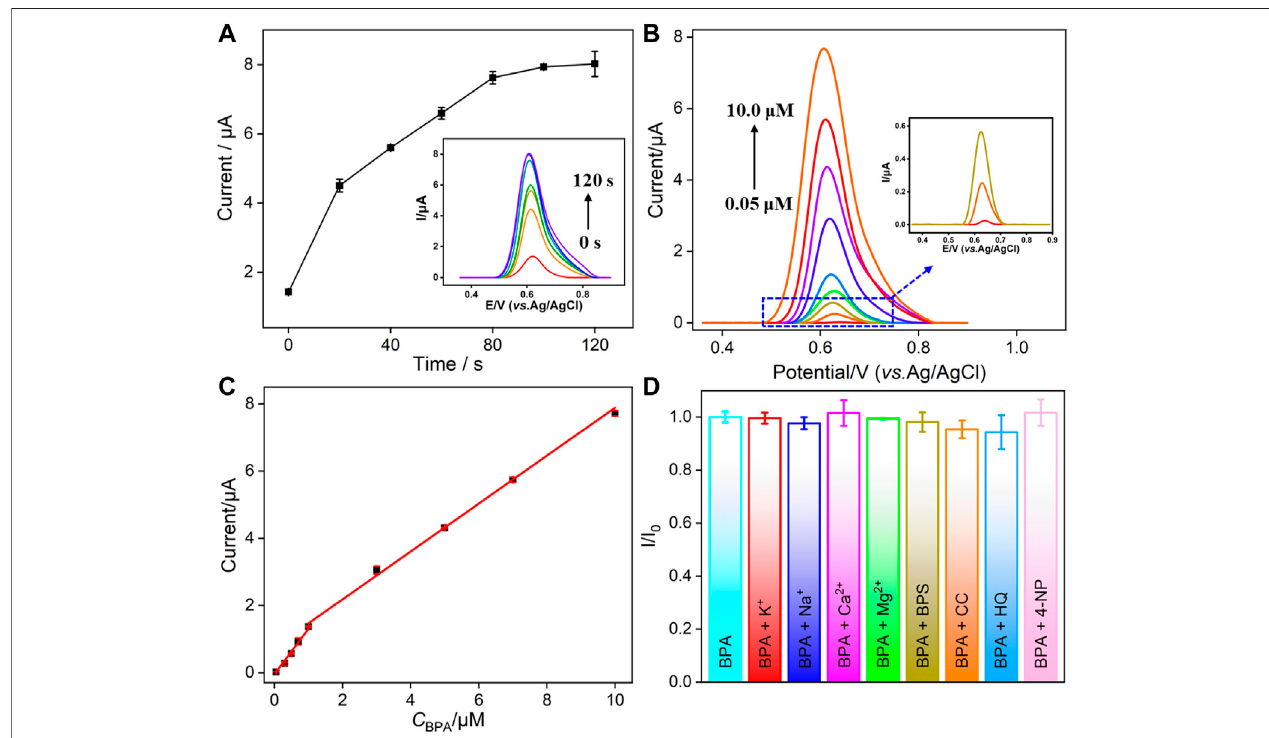
FIGURE4|(A) DependenceofthestirringtimeonthecurrentresponseofBPAonVMSF/p-GCE.InsetisthecorrespondingDPVcurves. (B) DPVcurvesofVMSF/ p-GCE obtained in PBS (0.1 M, pH = 6) containing different concentrations of BPA after stirring for 100 s. Inset is the magni fi ed view of the DPV curves in the low- concentration region. (C) Calibration curve for BPA. (D) The current ratio ( I / I 0 ) obtained from VMSF/p-GCE for the detection of BPA (5.0 μ M) in the absence ( I 0 ) and presence ( I ) of 5-fold (BPS and 4-NP) or 50-fold of other added interfering species. The error bars represent the standard deviation (SD) of three measurements.